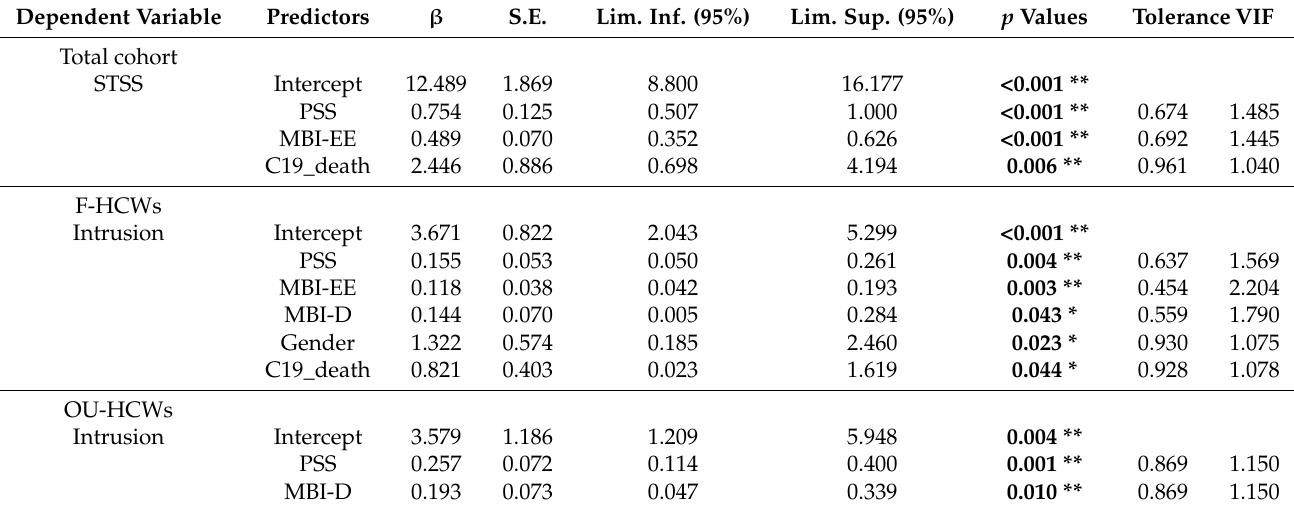
Table 7. Results of stepwise multiple linear regression analysis predicting secondary traumatic stress (STSS) in the total cohort (n = 184) and Intrusion in F-HCWs (n = 118) vs. OU-HCWs (n =